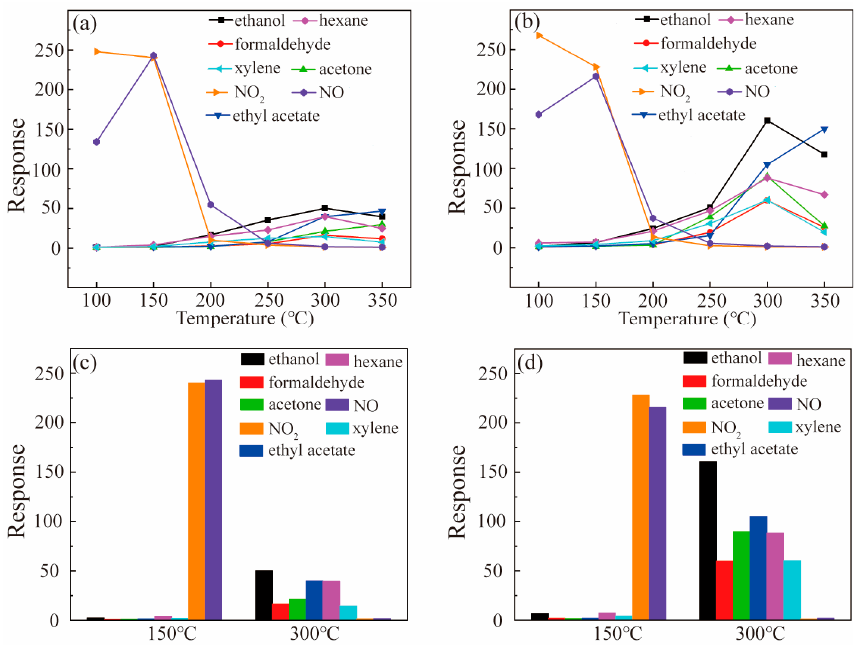
Figure 4. Response curves of ( a ) SnO 2 and ( b ) Pt-SnO 2 to different gases in the whole temperature range; response curves of ( c ) SnO 2 and ( d ) Pt-SnO 2 to different gases under 150 °C and 300 °C . Dynamic resistance curves of SnO 2 to 1 ppm NO and 10 ppm C 2 H 5 OH at 150 °C are